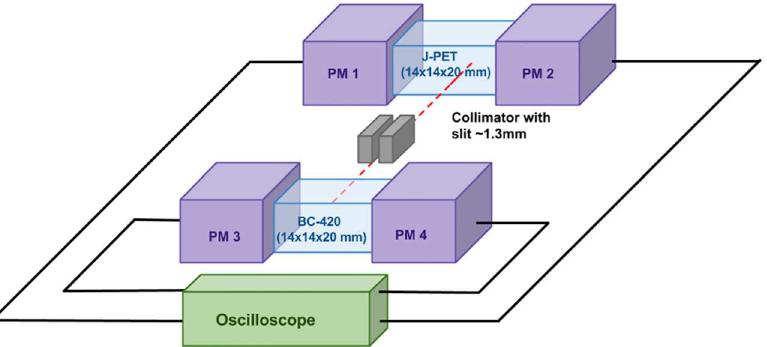
Fig 4. Scheme of the experimental setup for the J-PET scintillators tests. PM denotes photomultiplier. As oscilloscope a Serial Data Analyser(Lecroy SDA6000A) was used. It allowedto collect waveforms of four photomultipliers’ signalssimultaneously with the samplingintervalof 100 ps.